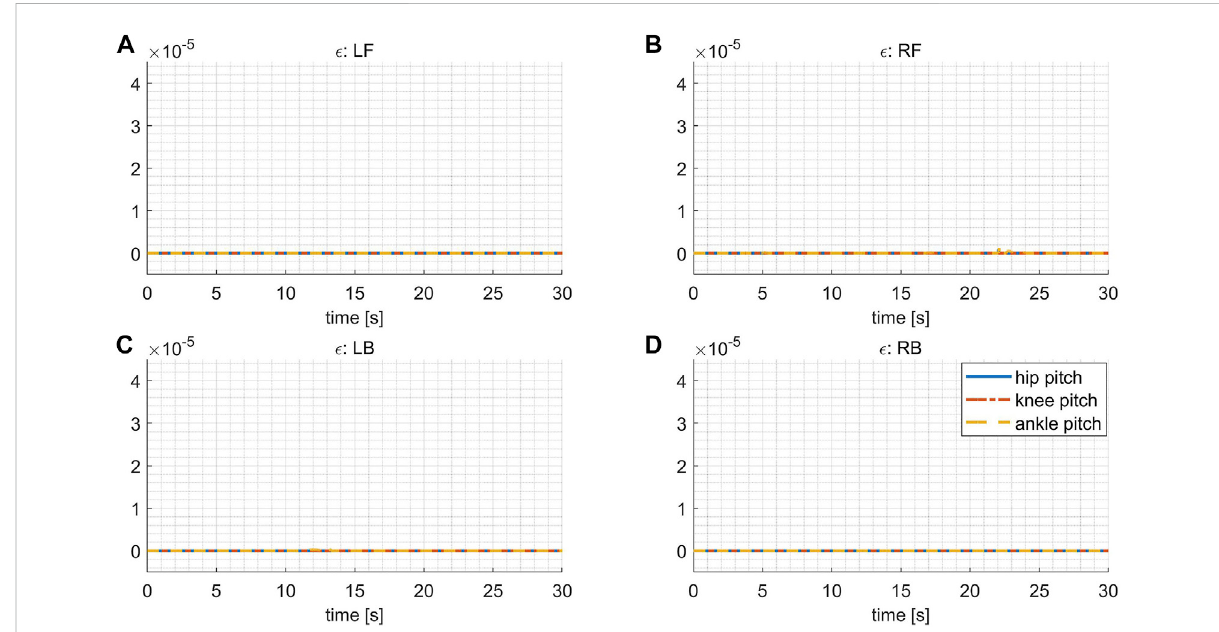
FIGURE 8 Theslackfactor  ofcontinuous torque limitsinthevariablestiffnesslocomotion. (A)  forthelegLF. (B)  forthelegRF. (C)  forthelegLB. (D)  for the leg RB.